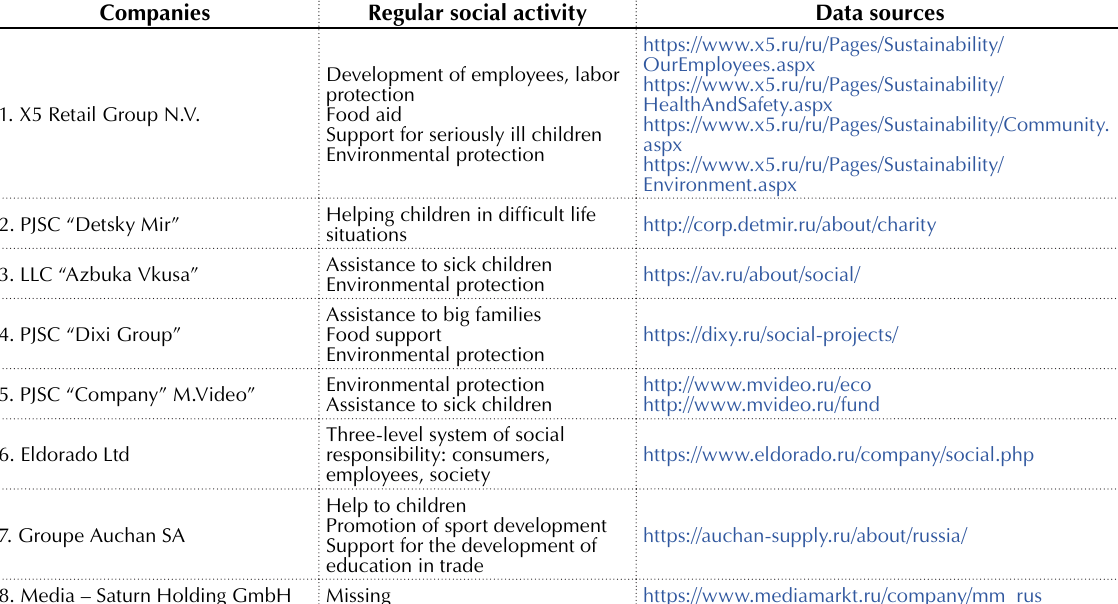
Source: compiled by the authors according to the companies’